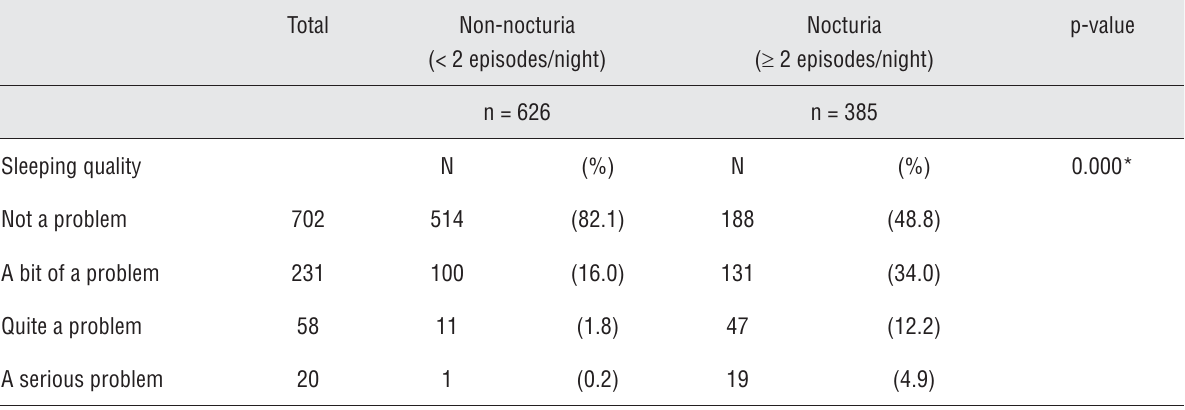
Table 2 - The impact on sleeping between participants with and without nocturia (  2 episodes/night).